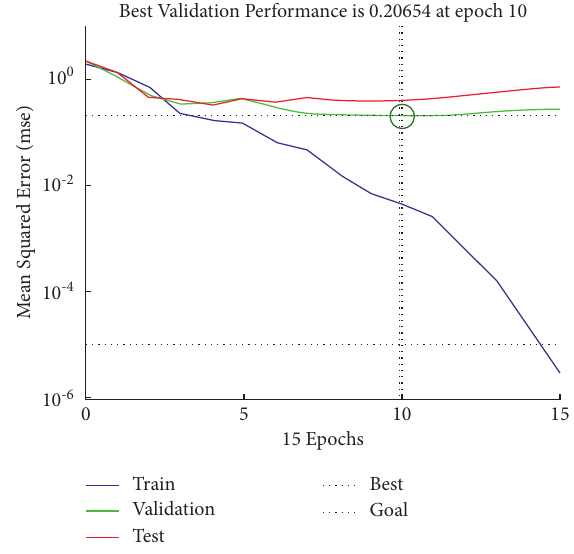
Figure 8: Error MSE drop